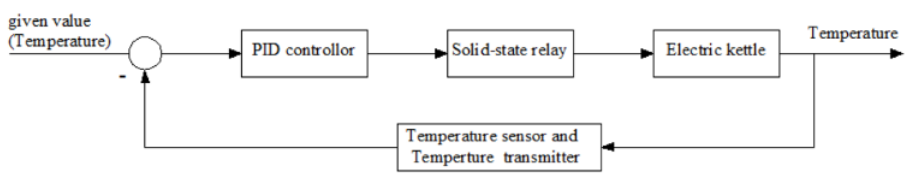
Fig. 1. The electric kettle temperature control system.